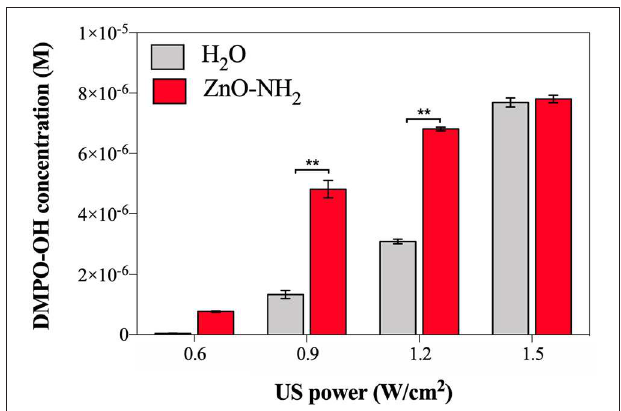
FIGURE 3 | DMPO-OH concentration (M) to evaluate ROS production after 10min of US irradiation according to different US powers, in presence of ZnO-NH 2 NCs (200 µ g/ml). All measurements were conducted in triplicate with 10% DC, 1 MHz frequency, using the LipoZero transducer. 1-way ANOVA was performed to determine statistical significance (* p < 0.05 and ** p <